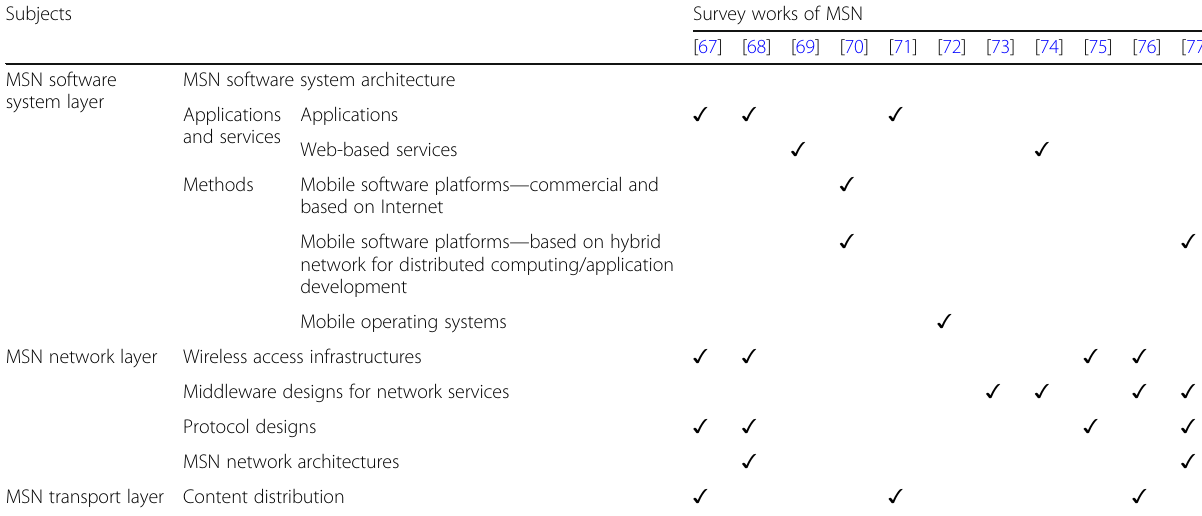
Table 1 Taxonomy of the current survey works of MSN